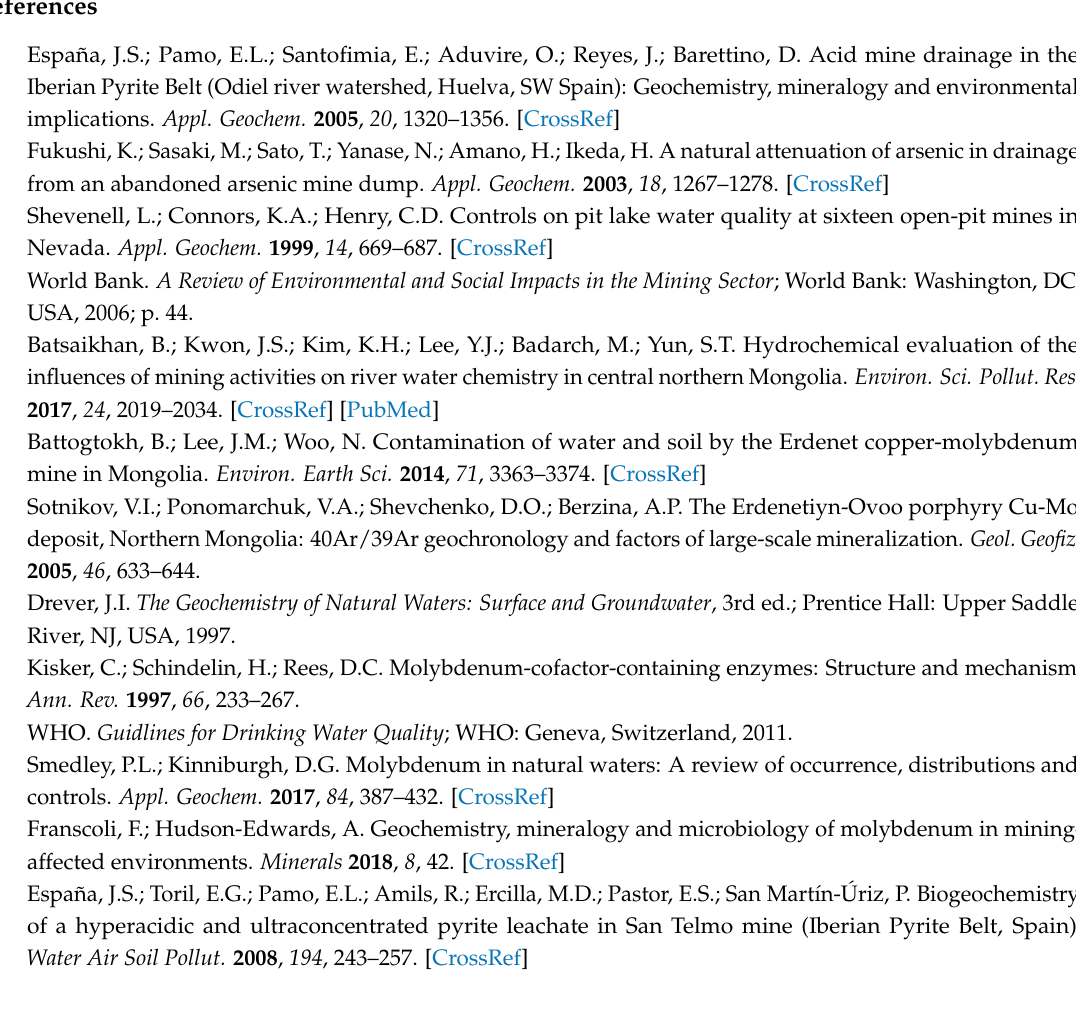
Figure A2. Results the sequential extraction of river (S4, Erdenet River; S7, Gavil River; and S8, Khangal River) and pond (S10.1 and S10.2) sediment samples for Mo, Fe, Mg, Ca, and Mn given in fraction.